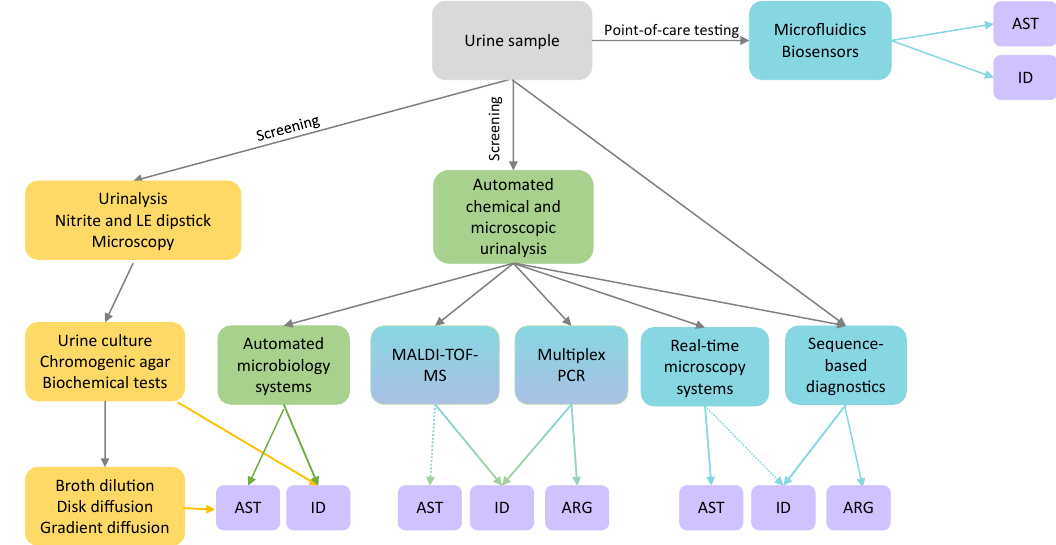
Figure 1: Laboratory methods for diagnosis of